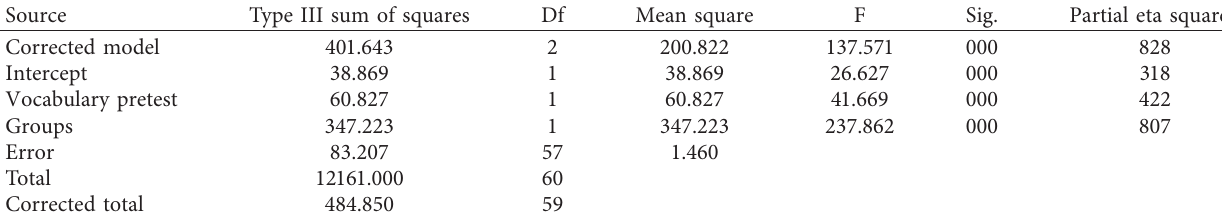
Table 4: One-way ANCOVA (both groups’ posttest).